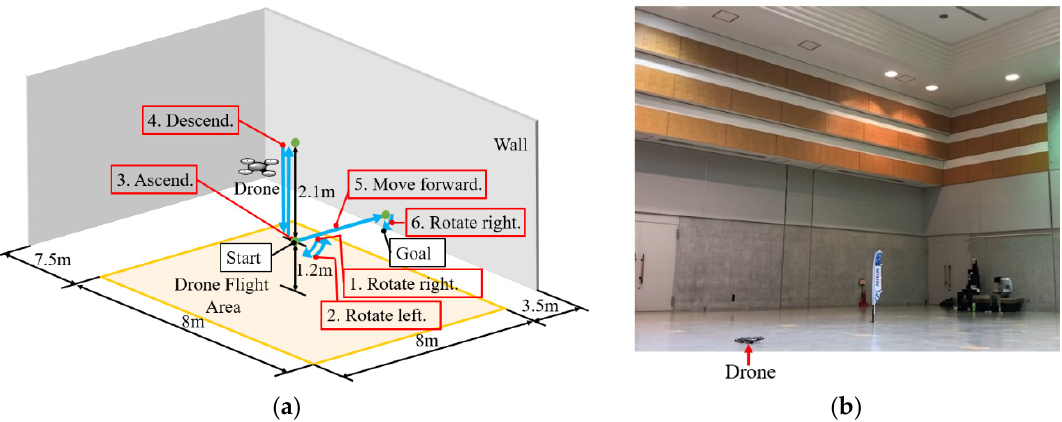
Figure 8. Flight course in the indoor experiment. ( a ) Flight course; ( b ) Real experimental set-up in a